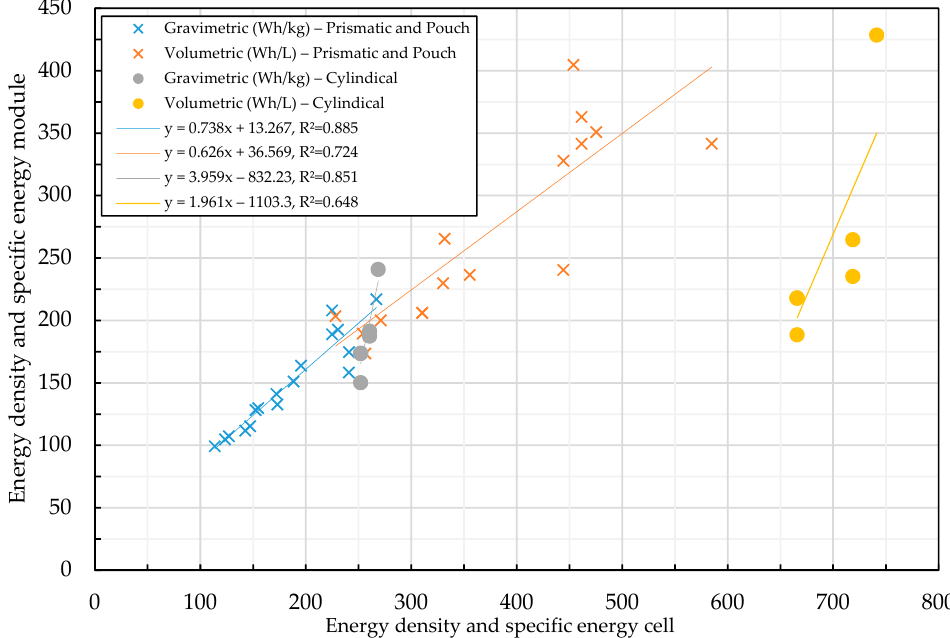
Figure 8. Scaling trend of energy density on cell level vs. energy density on module level.